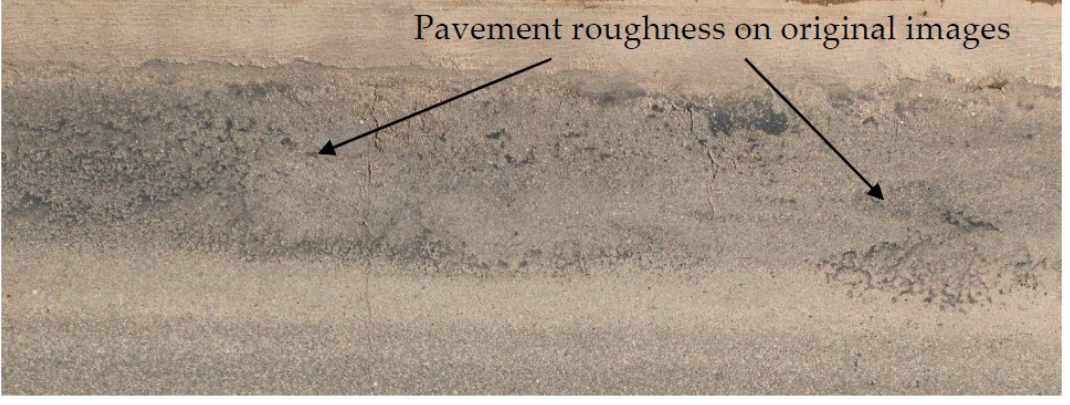
Figure 19. Original drone image highlighting pavement roughness.